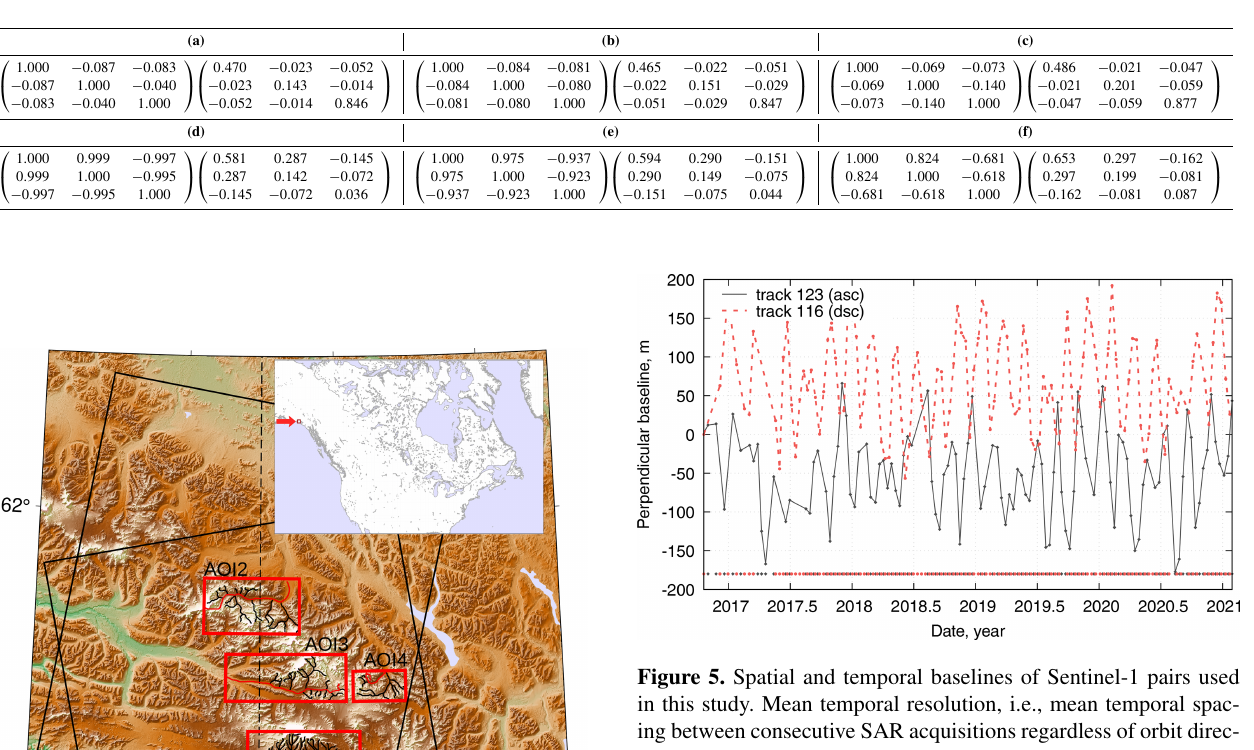
Table 2. Correlation (first matrix in cell) and covariance (second matrix in cell) matrices of north, east, and vertical components of velocity for six synthetic tests shown in Fig. 3. Labels (a) – (f) correspond to subfigures in Fig. 3. Columns are in order – north, east, vertical. Units of covariance matrix terms are ( myr − 1 ) 2 .